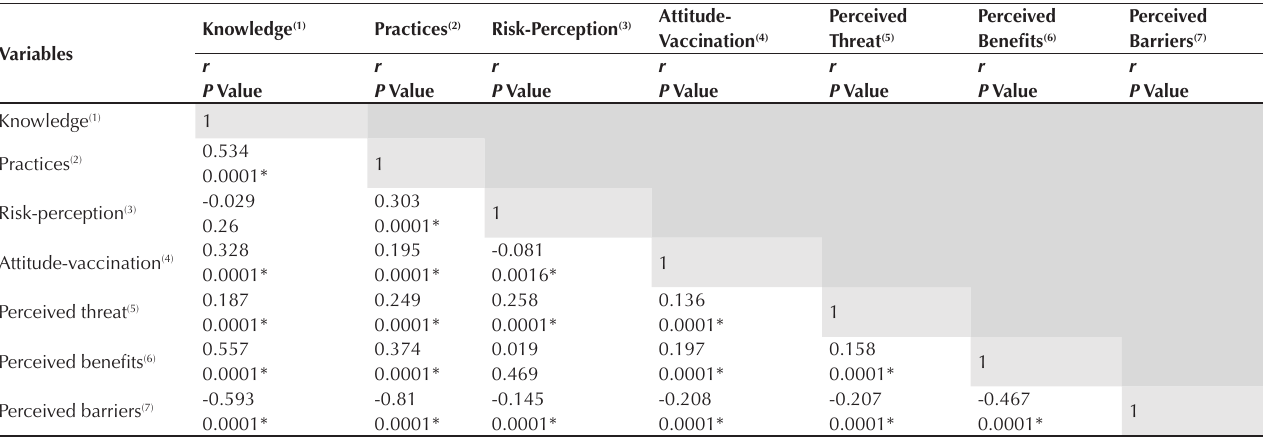
Table 8. Correlation Matrix Between Scores of Different Elements of KAP and Each Other Among the Studied